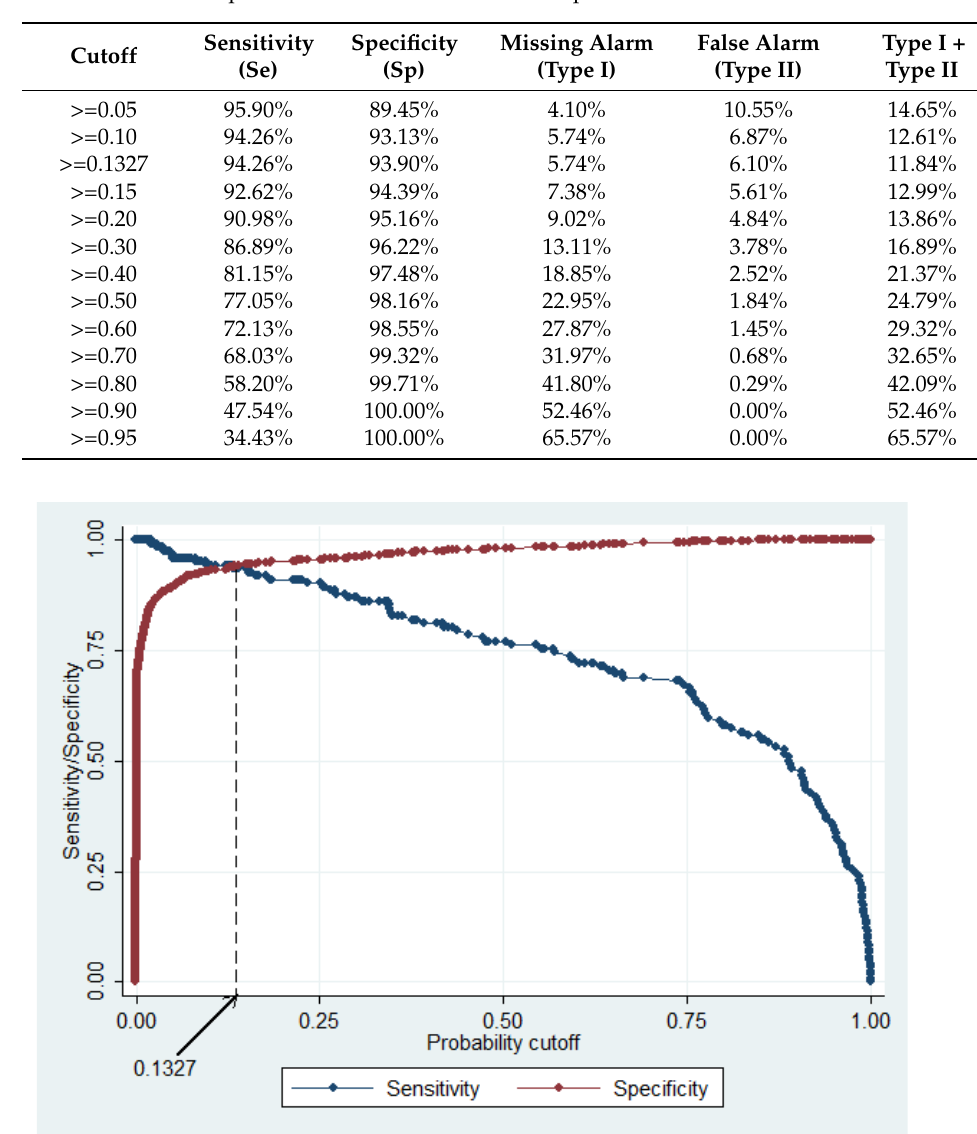
Figure 3. Optimal cut-off threshold of the 12-month EWS model in Asian countries.